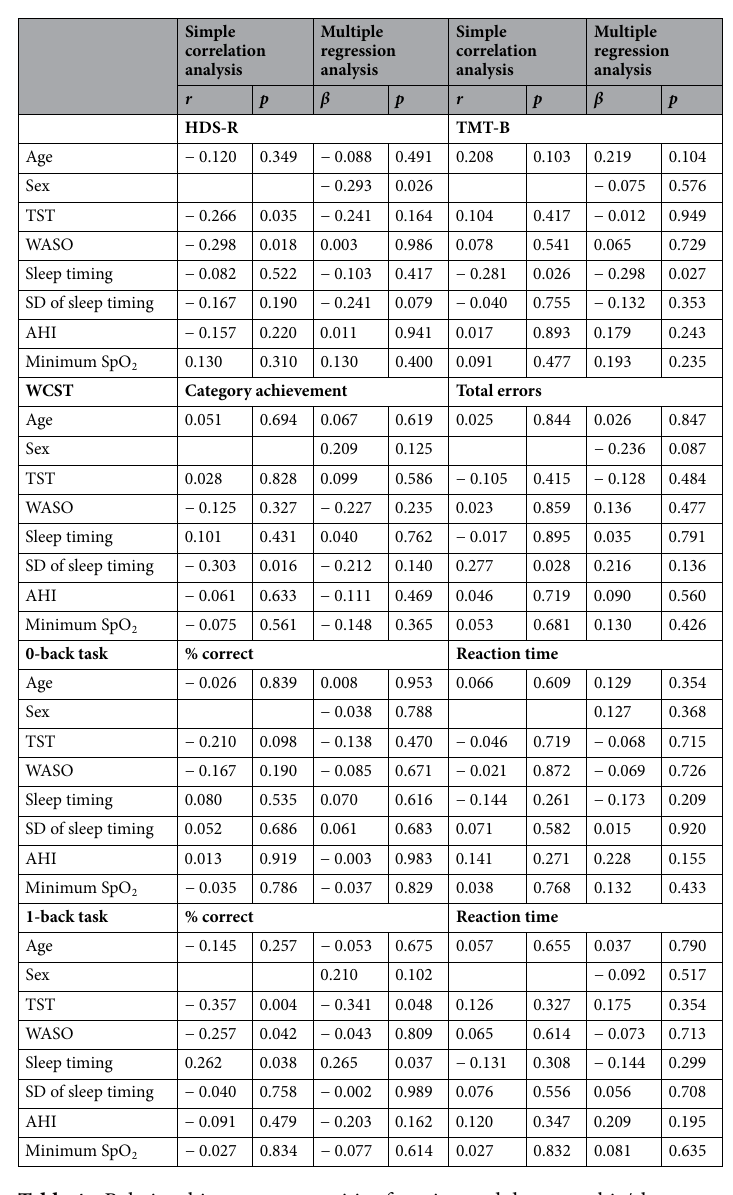
Table 4. Relationships among cognitive function and demographic/sleep parameters. HDS‑R revised Hasegawa’s dementia scale, TMT‑B trail making test B, TST total sleep time, WASO wake after sleep onset, SD standard deviation, AHI apnoea-hypopnea index, WCST Wisconsin card sorting